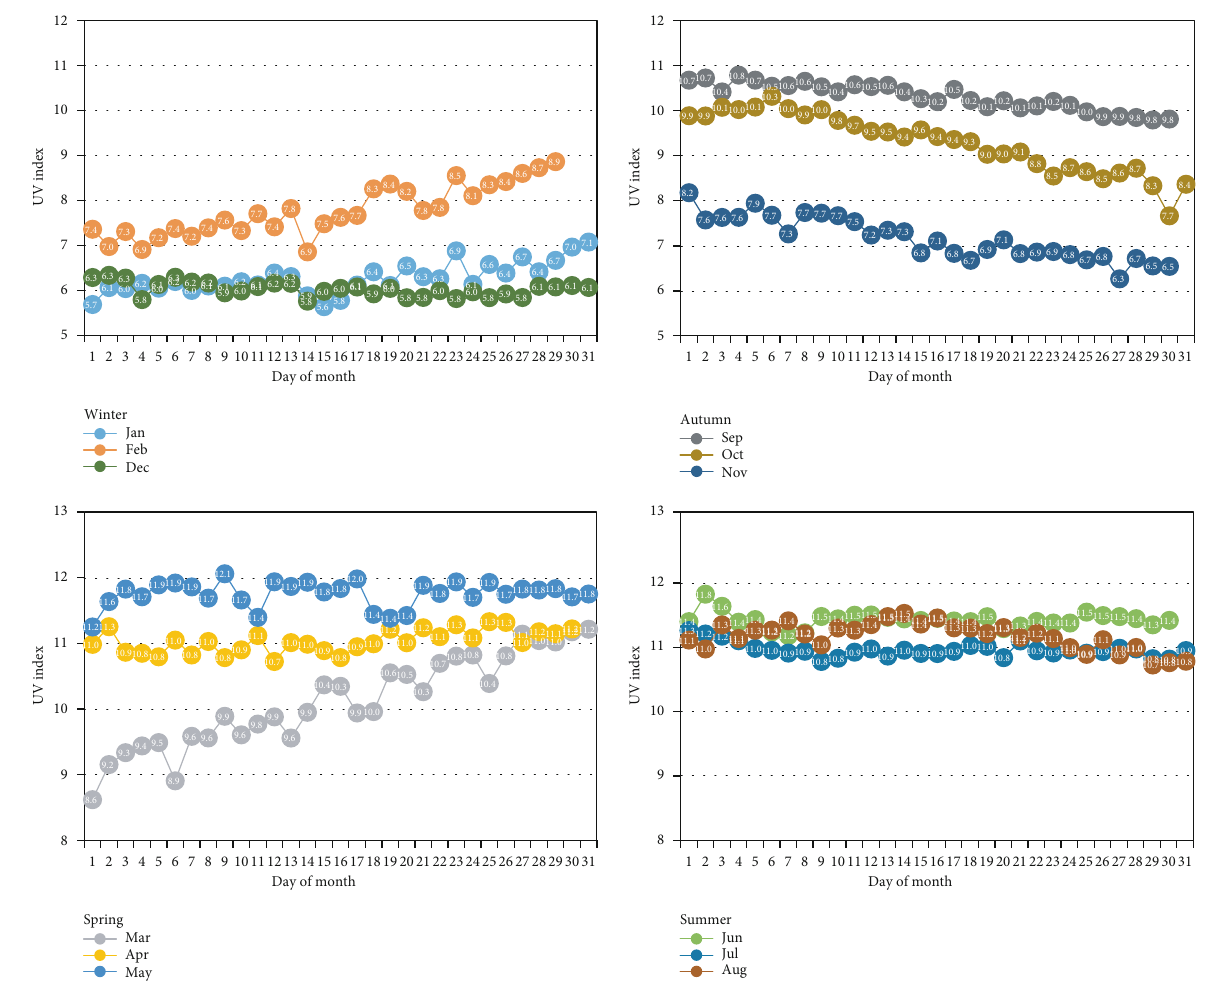
Figure 7: Seasonal variations in the UVI on the campus of KAU during the study